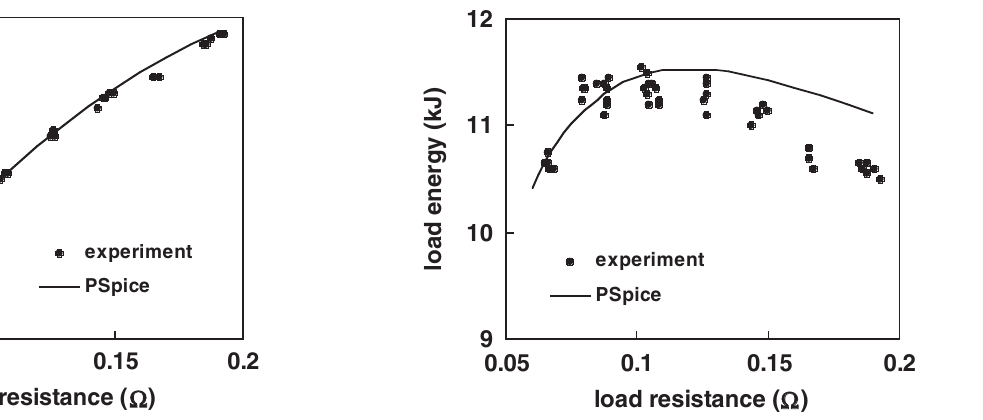
FIG. 4. Peak load voltage dependence on the load resistance. The dots are the experimental results while the solid curve is the PSPICE simulation.